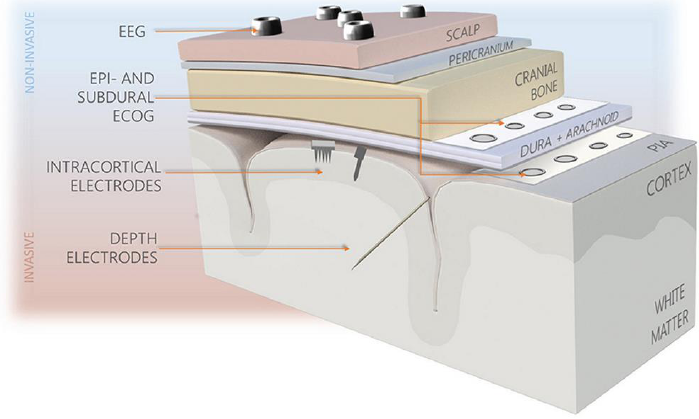
Figure 2. Types of brain interfacing electrodes and their locations in reference to the brain. Reproduced with permission from Creative Commons open access policy from